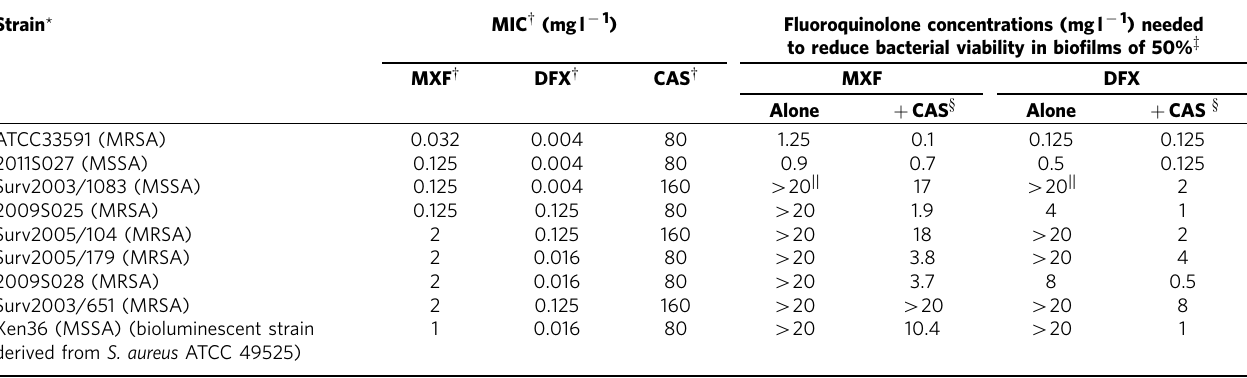
Table 1 | Activity of moxifloxacin and delafloxacin alone or combined with caspofungin against planktonic bacteria and 24-